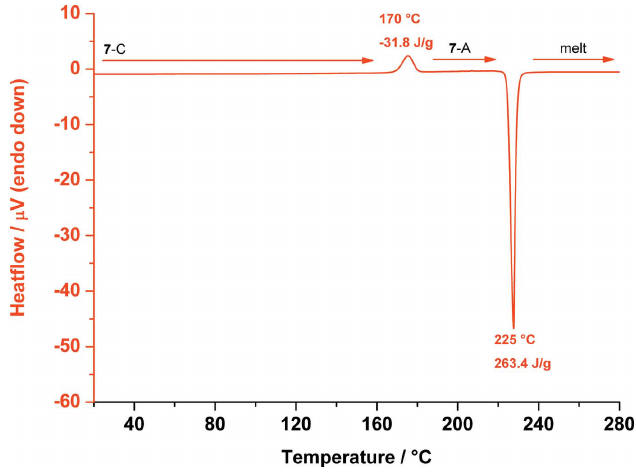
Figure 19 DSC trace of myo -inositol ( 7 ) measured from 20 up to 280 (cid:2) C showing the phase transition of 7 -C back to 7 -A at 170 (cid:2) C, and the melting point of polymorph 7 -A at 225 (cid:2)